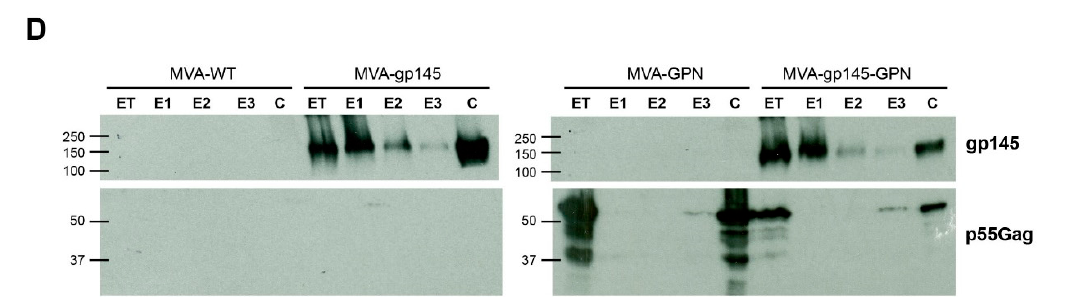
Figure 1. In vitro characterization of modified vaccinia virus Ankara (MVA)-based recombinant viruses expressing gp145 and/or Gag(ZM96)-Pol-Nef(CN54) (GPN) antigens. ( A ) Confirmation of HIV-1 gp145 and/or GPN insertion by PCR analysis. Viral DNA was extracted from DF-1 cells infected with MVA-WT, MVA-gp145, MVA-GPN or MVA-gp145-GPN at 5 pfu/cell. Primers thymidine kinase-L (TK-L) and TK-R spanning J2R (TK) flanking sequences or primers HA-MVA and HA-II spanning A56R (haemagglutinin (HA)) flanking sequences were used for PCR analysis of TK or HA loci, respectively. In parental MVA, a 853 bp-product corresponding to parental TK locus is obtained, while in MVA-gp145 and MVA-gp145-GPN a unique 2577 bp-product is observed and in MVA-GPN a unique band of 4500 bp is detected. Regarding the HA locus, a 750 bp-product is observed in MVA-WT, MVA-gp145 and MVA-GPN samples, while in MVA-gp145-GPN a unique 4500 bp-product is obtained. ( B ) Analysis of virus growth in a permissive cell line. Monolayers of CEF cells were infected with MVA-WT, MVA-gp145, MVA-GPN or MVA-gp145-GPN at 0.1 pfu/cell. At different times post-infection (0, 24, 48 and 72 h), the cells were collected and infectious viruses were quantified by immunostaining plaque assay in DF-1 cells. ( C ) Time-course expression of HIV-1 antigens by Western-blot analysis. Monolayers of DF-1 (left panels) or HeLa (right panels) cells were infected at 5 pfu/cell with MVA-WT, MVA-gp145, MVA-GPN or MVA-gp145-GPN viruses. At different times post-infection (0, 4, 8 and 24 h), the infected cells were collected, cells extracts fractionated by 10% SDS-PAGE, and analyzed by Western-blot using rabbit polyclonal anti-gp120 (upper panels) or anti-gag p24 (lower panels) antibodies to evaluate the expression of gp145 and Gag antigens, respectively. ( D ) Fractionation of viral proteins and localization of HIV-1 Env and Gag proteins within purified MVA-based recombinant viruses. Sucrose-purified virions from MVA-based recombinants were sequentially disrupted by treatment with detergents and different fractions were isolated, as described under Materials and Methods. The unfractionated lysate virions (total extract, ET) and the collected fractions (E1, E2, E3 and C) were analysed by Western-blot using anti-gp120 or anti-Gag